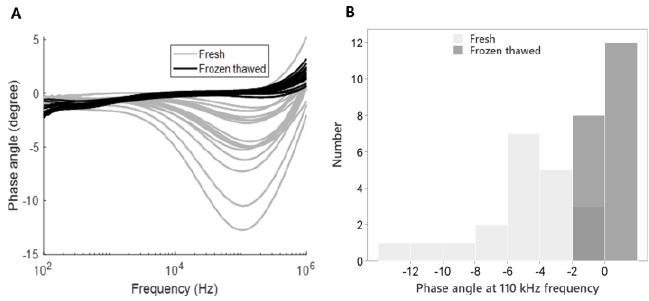
Figure 3. Individual impedance phase angle responses in pork before and after freezing-thawing (N=20 per treatment group). A. The phase angle of refrigerated and frozen-thawed meat measured in one specific position. B. The distribution of phase angle values at 110 kHz reveals apparent differences between refrigerated and frozen-thawed